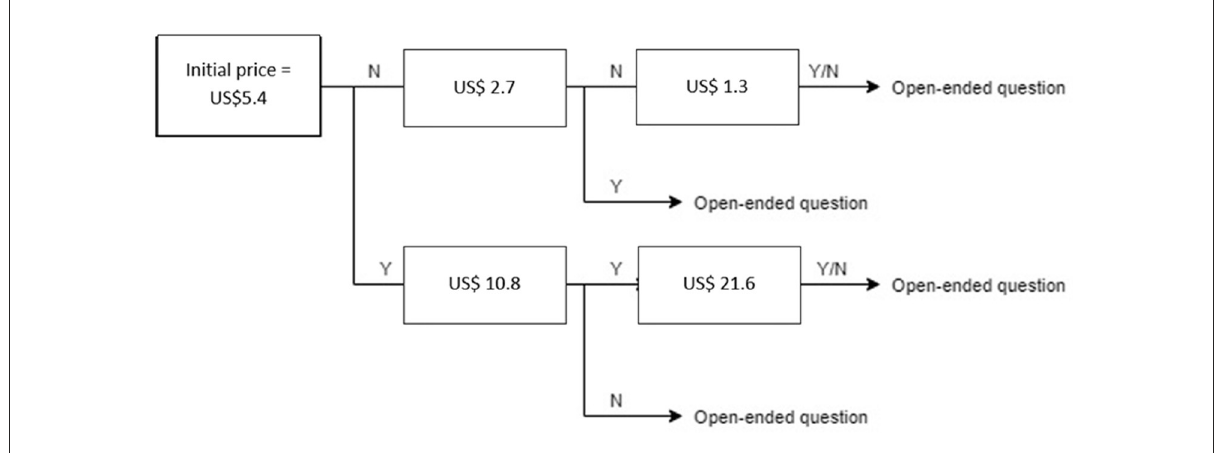
FIGURE1 Contingent valuation of willingness to pay. Y, yes; N,